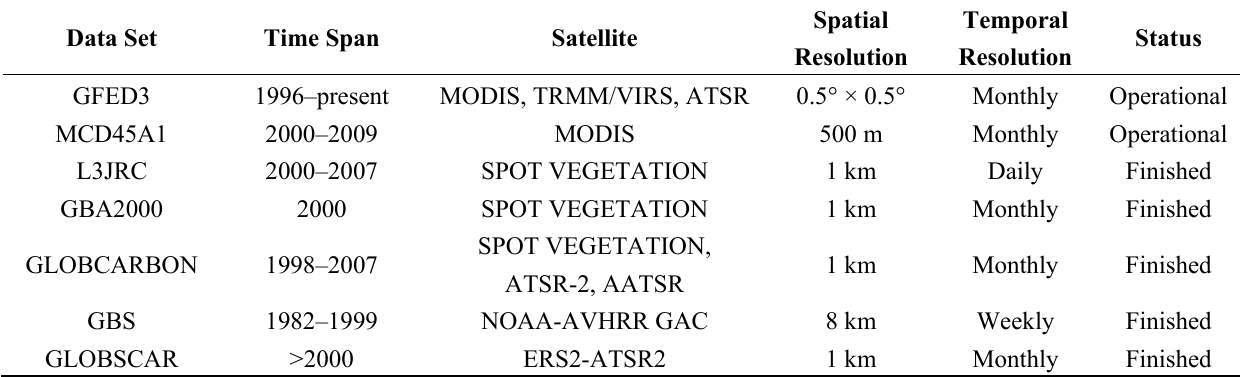
Table 2. Global forest fire initiatives developed from remote sensing